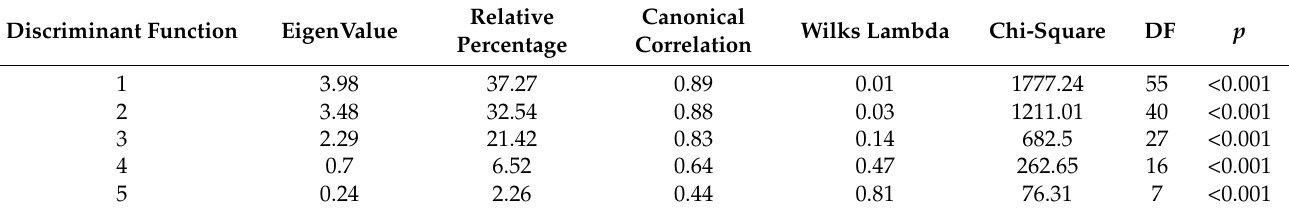
Figure 2. Honey samples distributed in five groups (cluster A, B, C, D and E) according to CA. Numerical nomenclature of honeys according to botanical origin: 1, chestnut; 2, blackberry; 3, eucalyptus; 4, heather; 5, honeydew; 6, multifloral. Table 4. Results of the statistics according to LDA. DF: degrees of freedom.